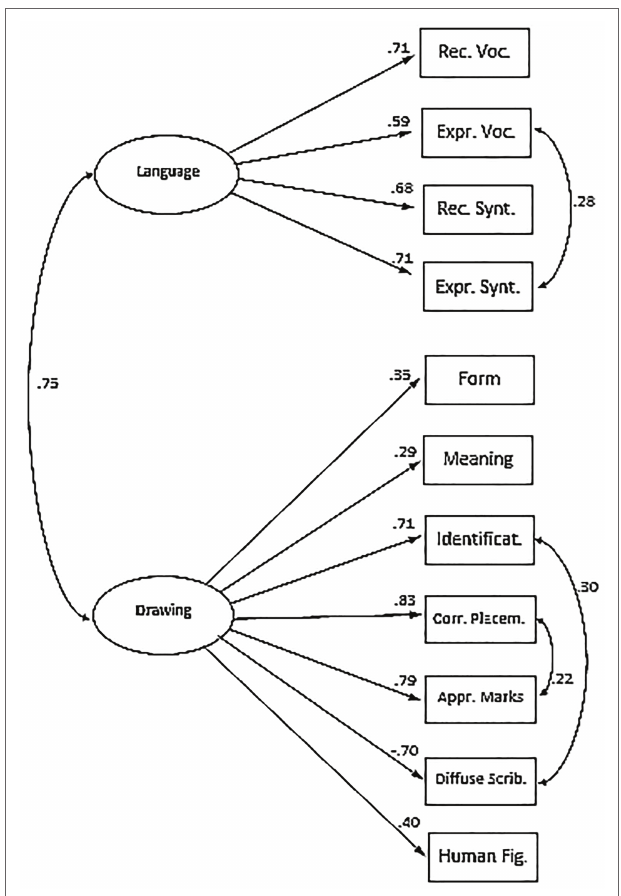
FIGURE 3 | Best-fitting measurement model (two-factor model with error covariances) for the language and drawing measures. Rec., receptive; Expr., expressive; Voc., vocabulary; Synt., syntax; Identificat., identifications; Corr. Placem., correct placements; Appr., appropriate; Scrib., scribbles; Fig.,